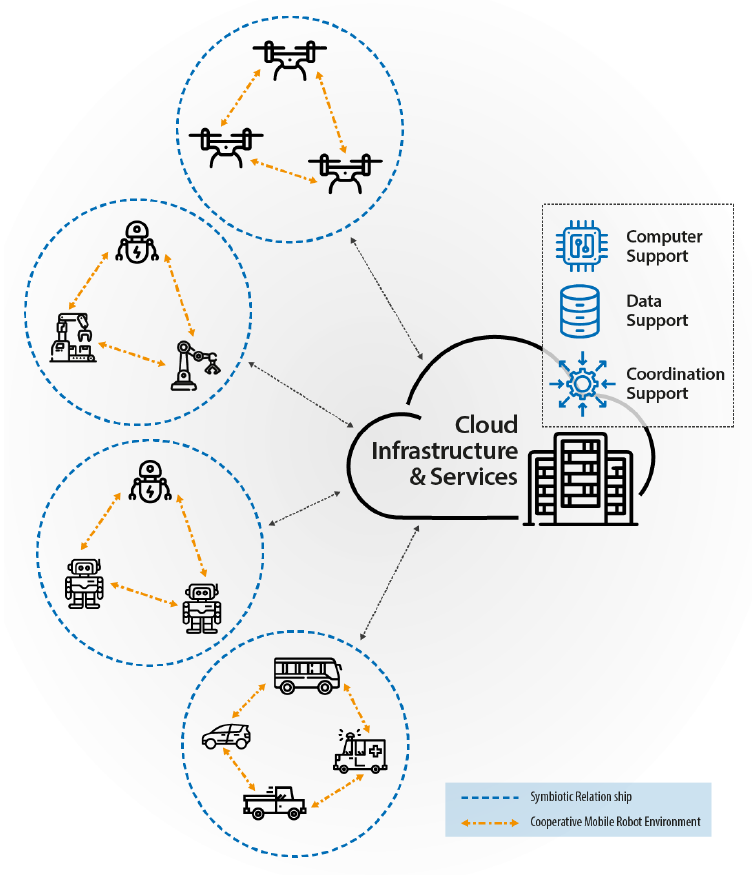
Figure 6. Collaborative robotics use